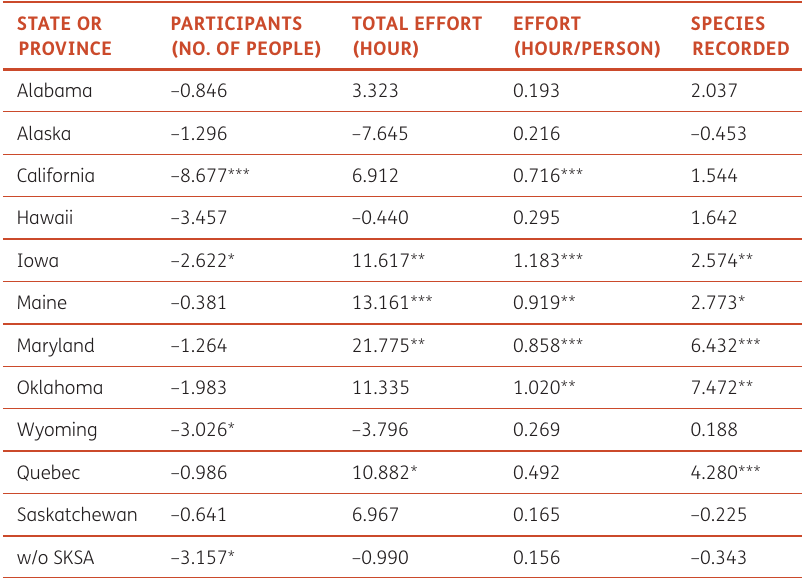
Table 3 Mean difference between actual values of numbers of participants and effort in Christmas Bird Count for 2020 and values predicted based on linear regression for the previous 10 years, for a subset of states and provinces. Negative numbers represent a decrease in 2020 relative to the expected values based on linear regression. With a Bonferroni Correction Factor applied, P-values < 0.001 are considered significant; other levels are shown for reference. SKSA: Saskatoon count.